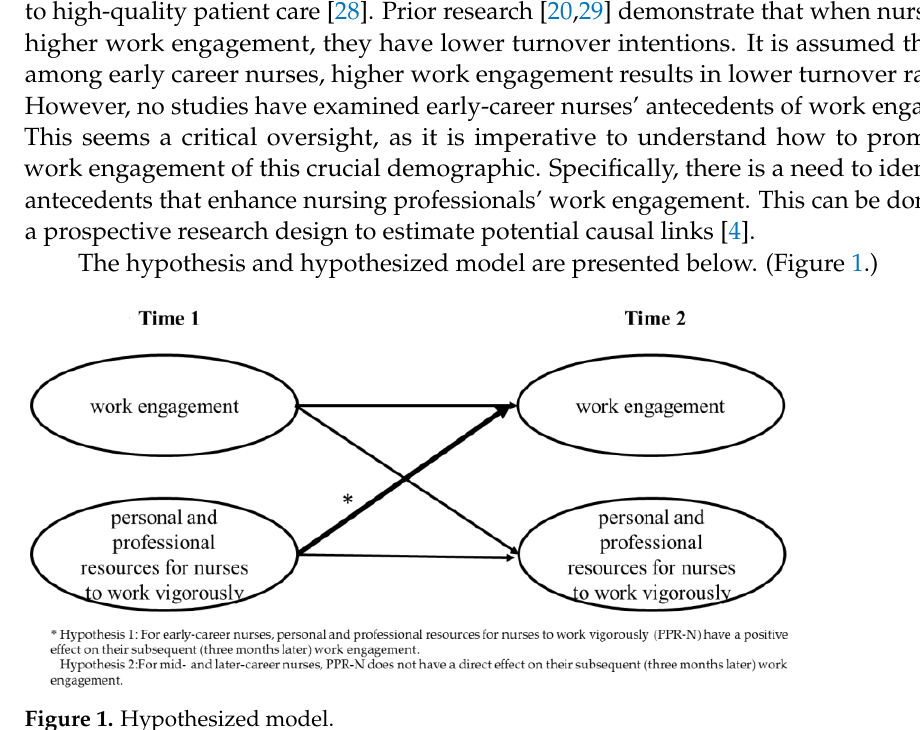
Figure 1. Hypothesized